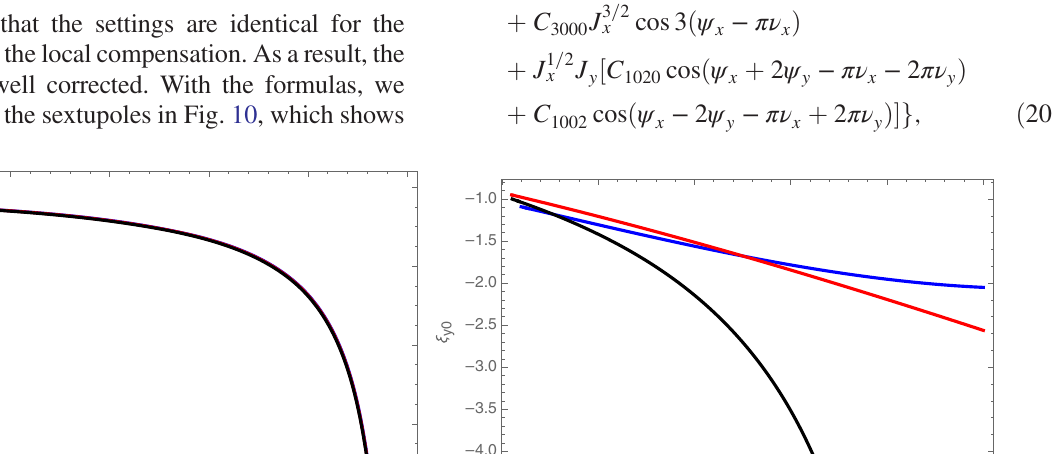
FIG. 8. Lattice functions of TME cell at the minimum emittance ν ν ; ν = 3 , ϕ ¼ π = 64 , and L ¼ 5 with ν x ¼ y ¼ min min